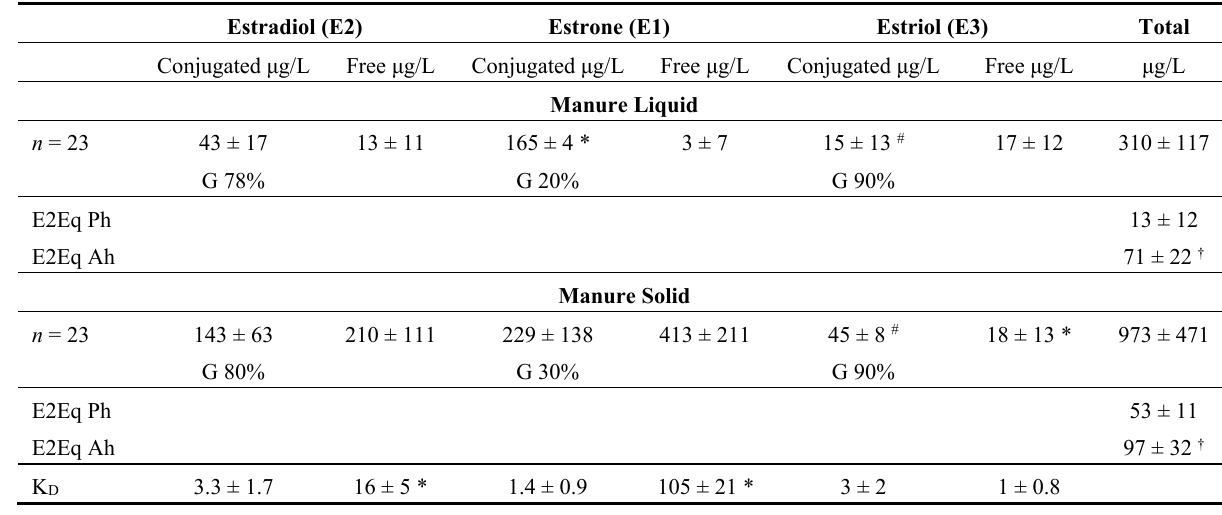
Table 1. Hormone levels in manure liquid and solid samples.